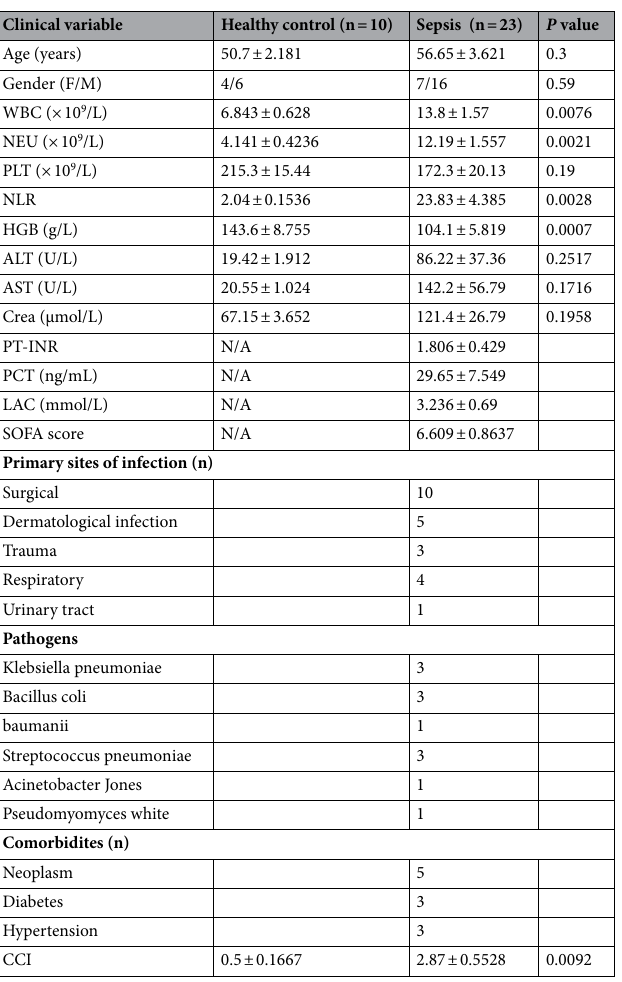
Table 1. Clinical information of the subjects. SOFA score Sequential Organ Failure Assessment score; WBC white blood count; NEU neutrophile; PCT procalcitonin; PLT platelet; NLR neutrophile/lymphocyte ratio; HGB hemoglobin; LAC lactic acid; ALT alaninetransaminase; AST aspartate aminotransferase; Crea creatinine; PT-INR prothrombin time/international normalization ratio; CCI Charlson Comorbidity